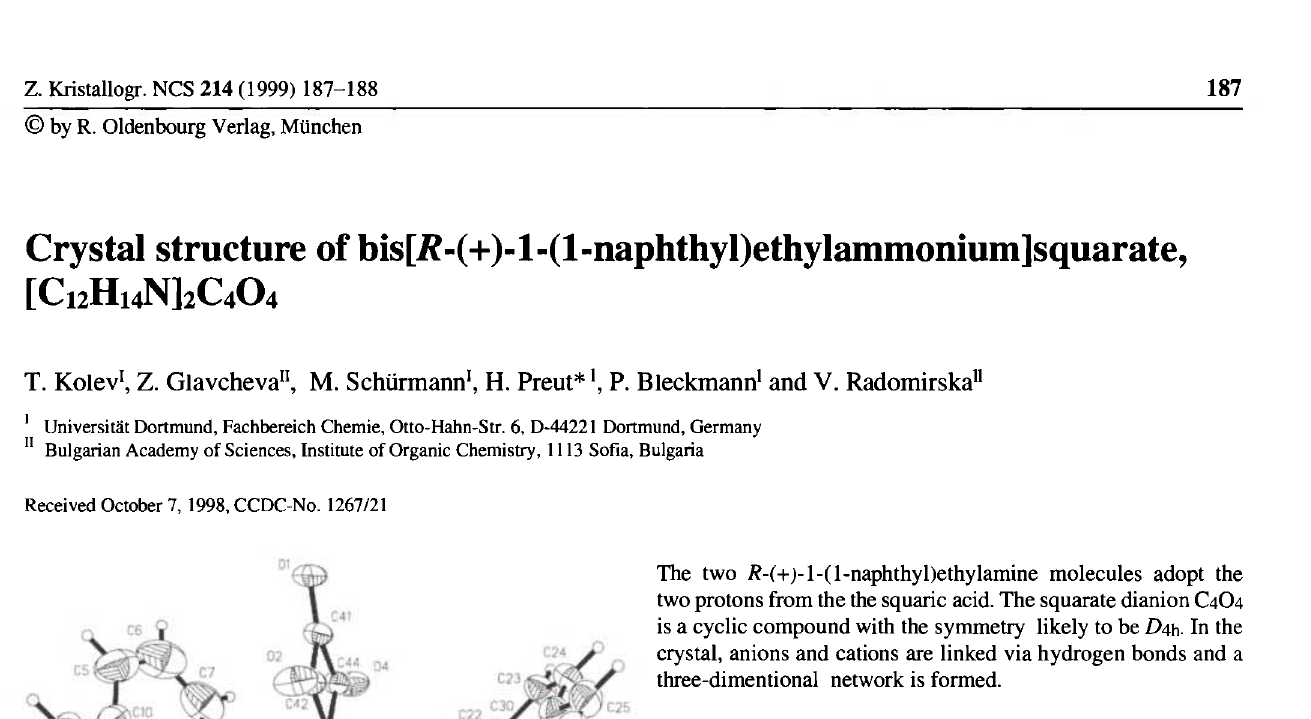
Table 1. Data collection and handling.